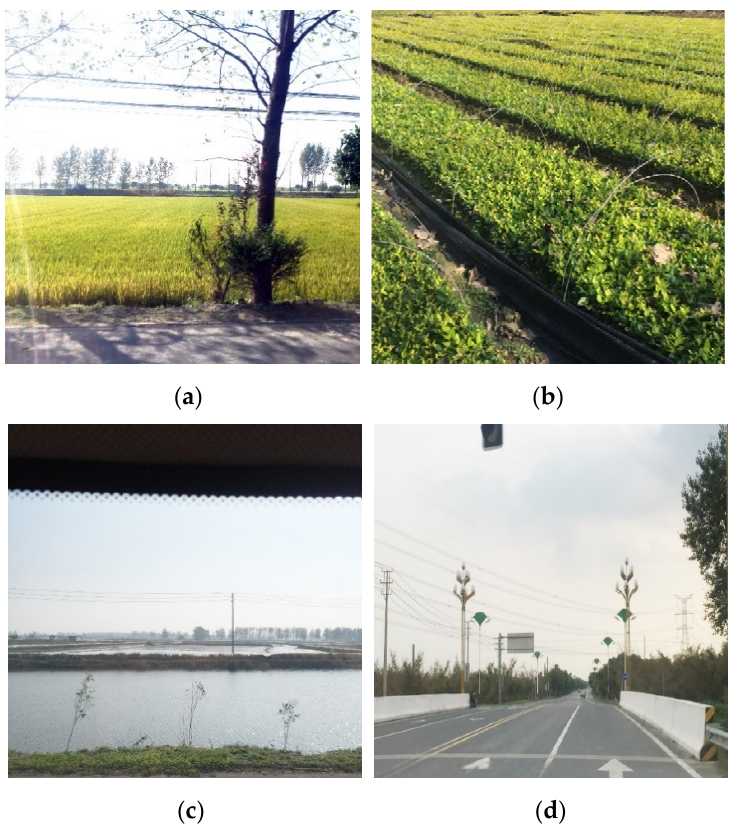
Figure 5. Ground survey photos, including paddy rice field ( a ), seedling field ( b ), waterbody ( c ),